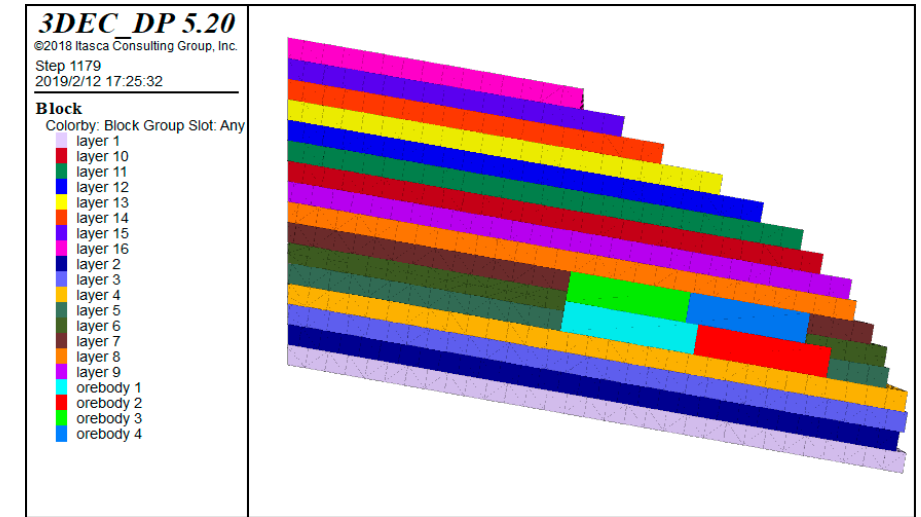
Figure 7. Elevation view of the 3-D numerical model.